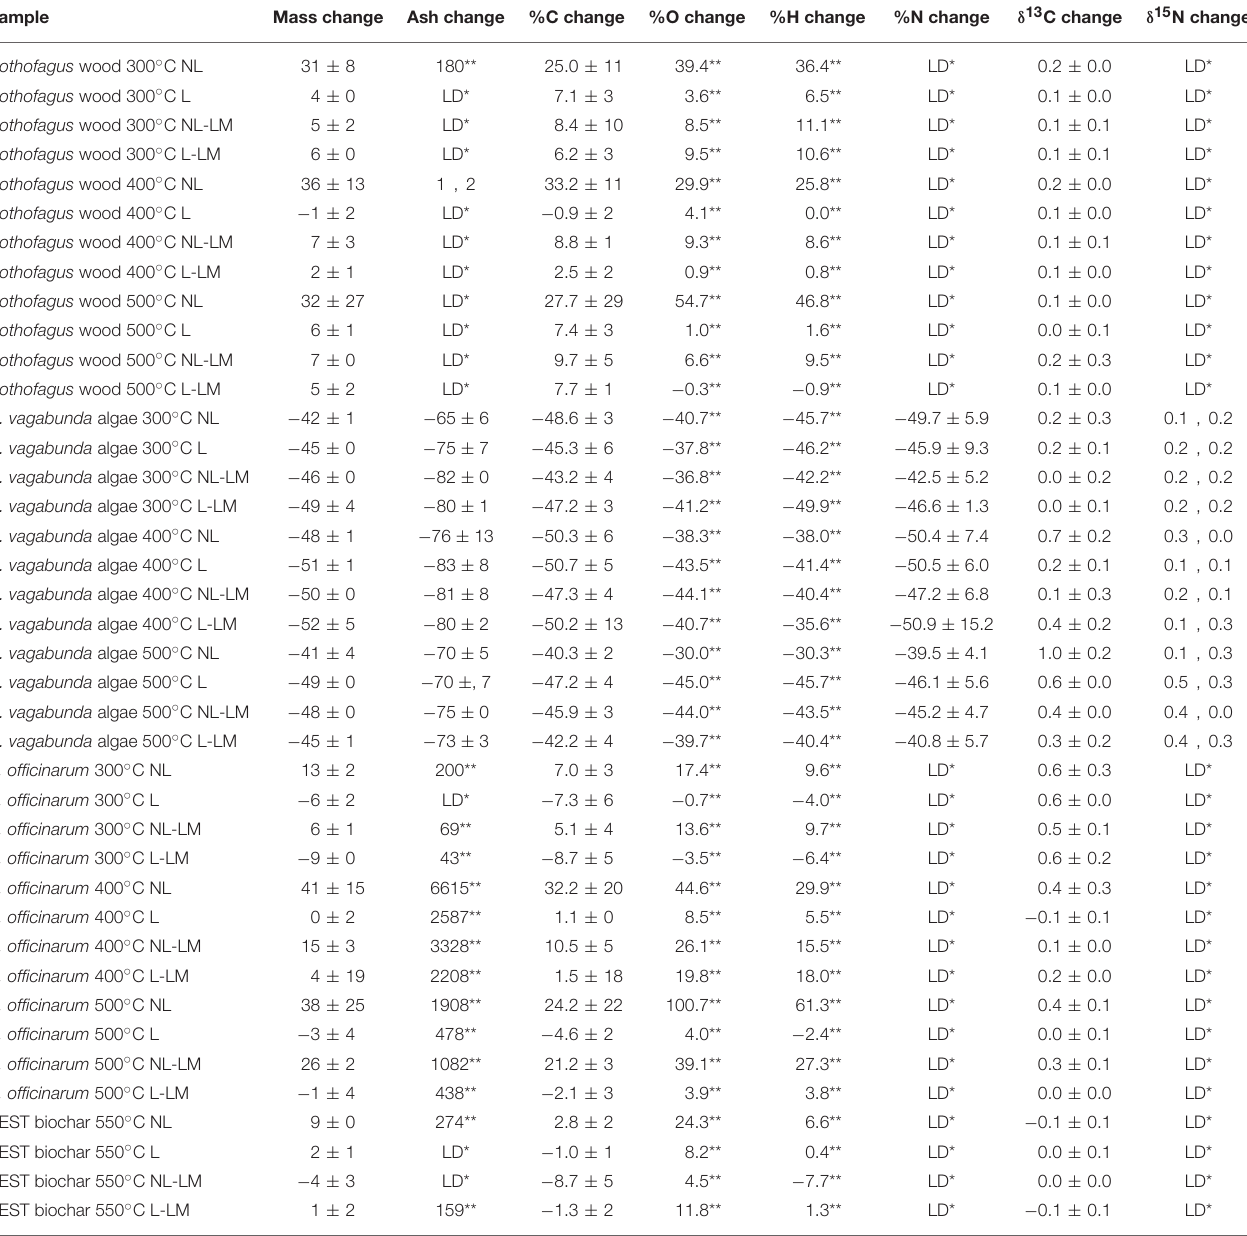
TABLE 2 | The proportional change following environmental exposure in sample mass, ash content, elemental abundance (%C, %O, %H, %N), expressed as % difference from starting values (as reported in Table 1 ), and the difference in stable isotope ratios ( δ 13 C and δ 15 N) after environmental exposure, expressed as ‰ deviation.